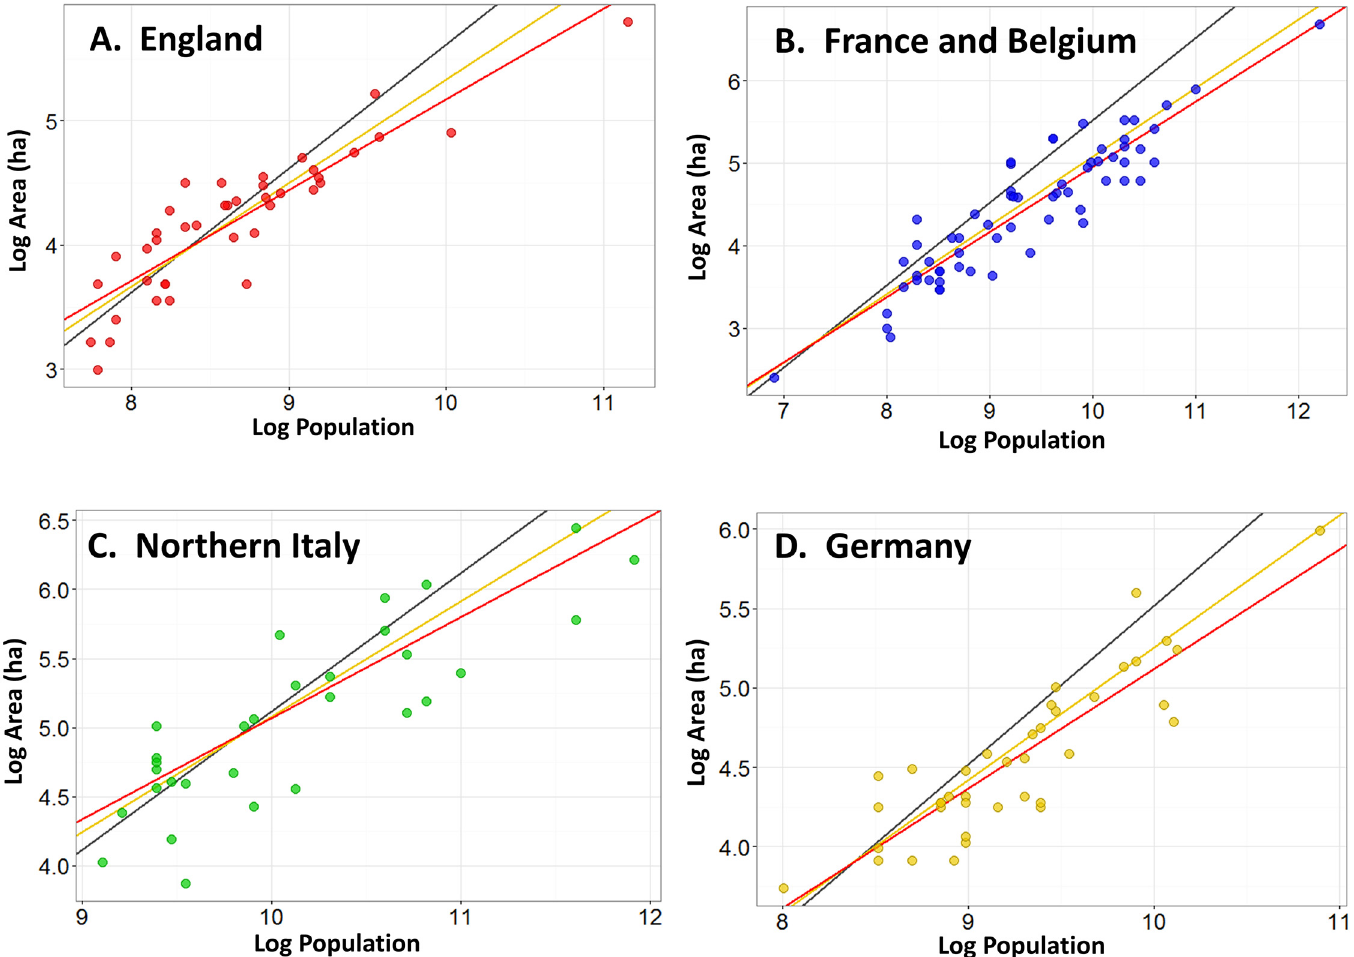
Fig 3. Estimation of Area — Population Scaling Relations for Regional Urban Systems. Estimation of Area — Population scaling relations for: (A) England (red); (B) France and Belgium (blue); (C) Northern and Central Italy (green); and (D) Germany (yellow). The black line represents proportionate (linear) scaling; the yellow line the theoretical prediction where α = 5/6; and the red line the best-fit line from OLS regression of the log-transformed